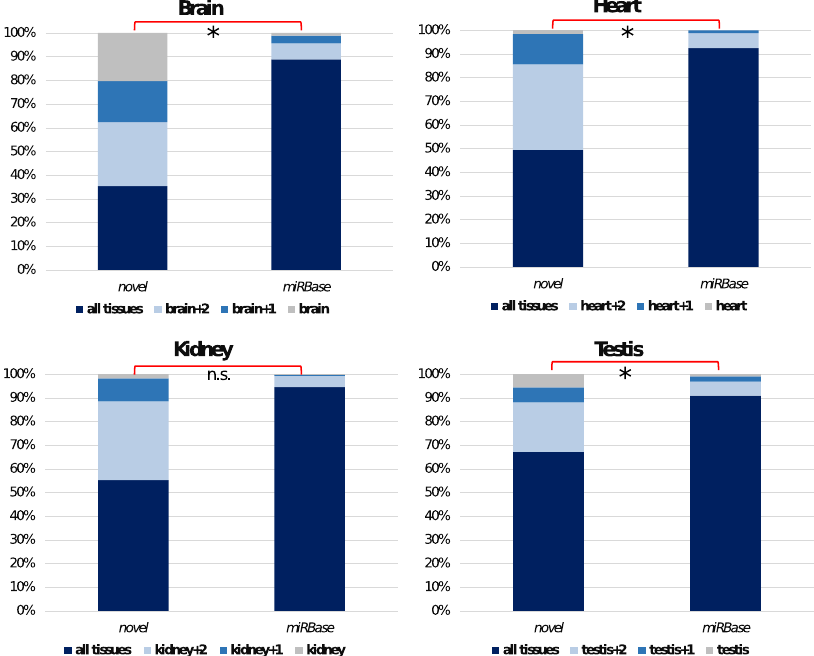
Figure 6. Expression patterns of novel and miRBase loci across 4 tissues. Colour labelling indicate the number of miRNA families expressed in a specific tissue, divided in the following categories: not expressed in the tissue considered; tissue specific; expressed in the tissue + n additional ones (n = 3 indicated as “all tissues”).